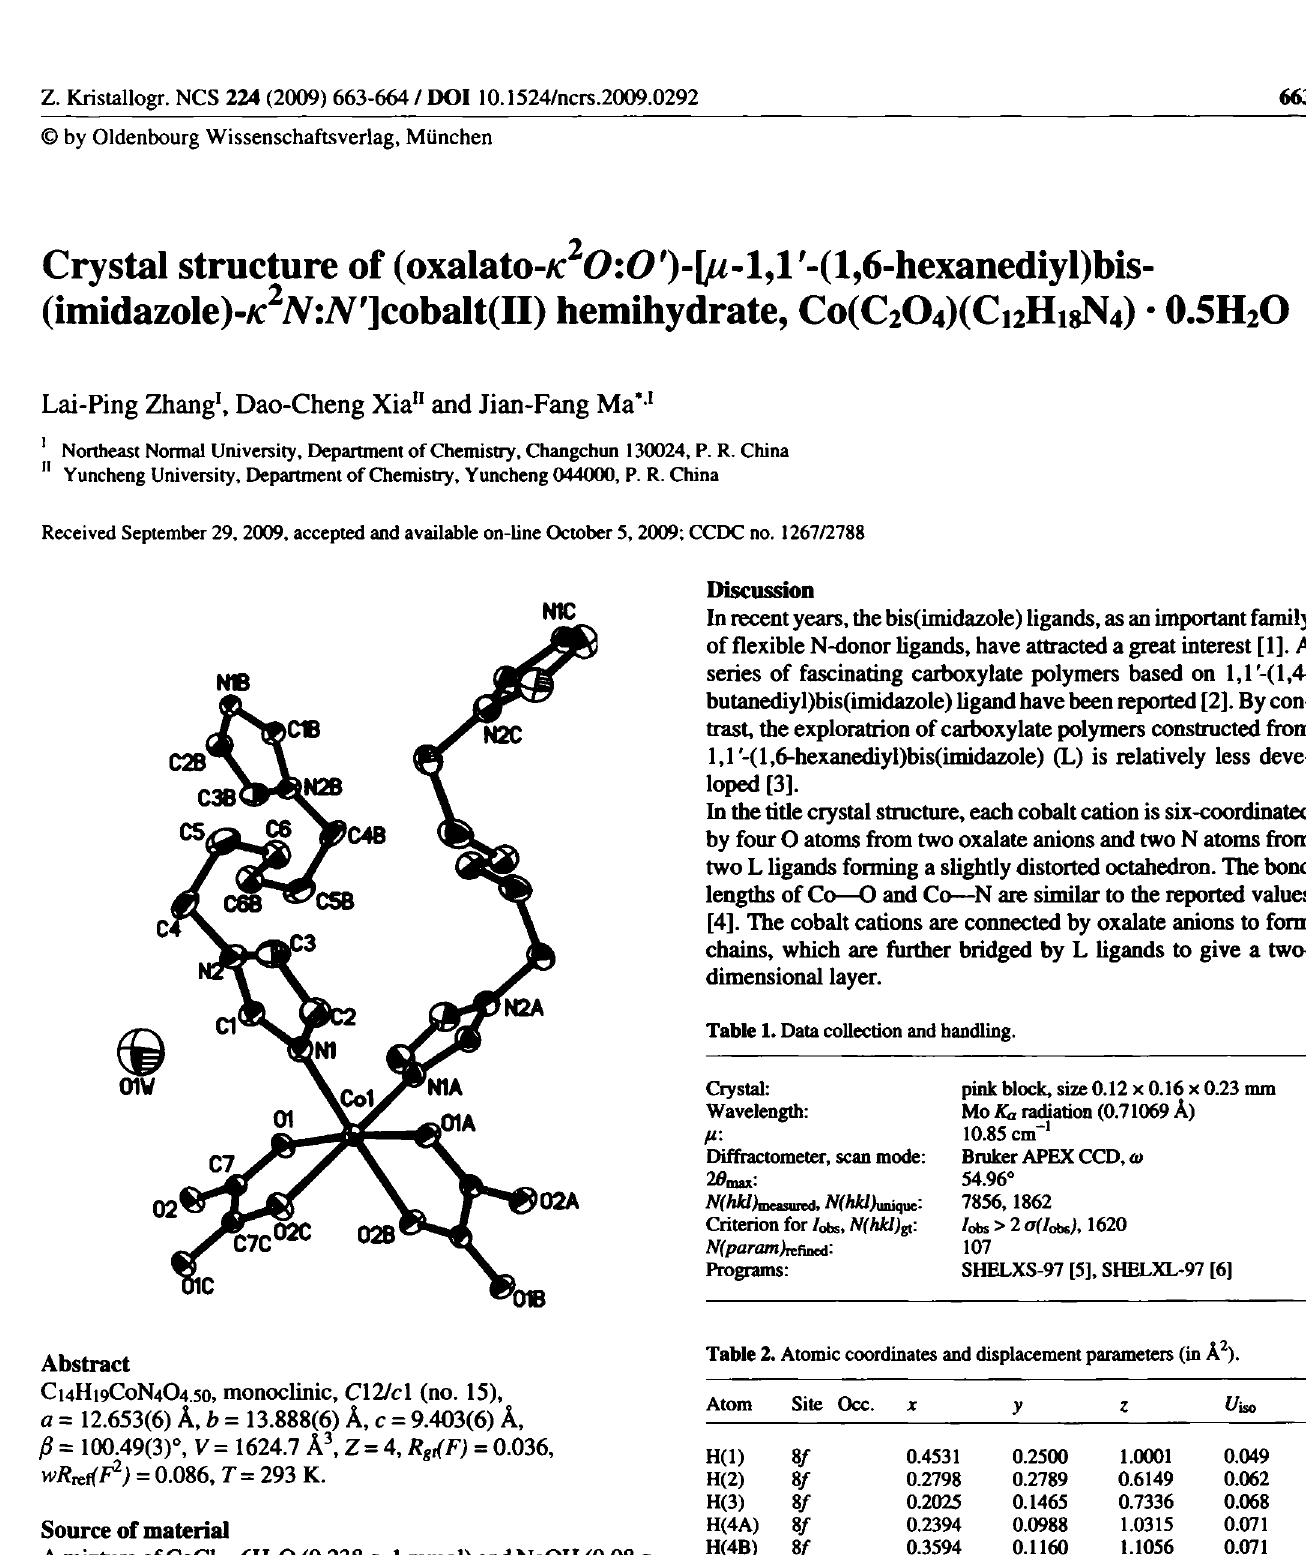
Table 2. Atomic coordinates and displacement parameters (in Â 2